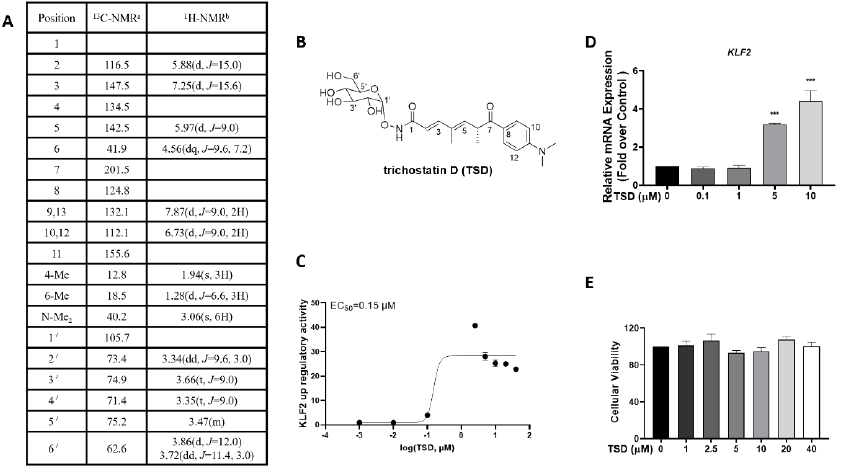
Figure 1. Trichostatin D (TSD) was identified as a novel Krüppel-like factor 2 (KLF2) activator. ( A ) Proton and carbon nuclear magnetic resonance spectroscopy ( 1 H-NMR and 13 C-NMR) data of TSD. ( B ) Chemical structure of TSD. ( C ) KLF2 dose-response curve of TSD. COS-7 cells were transfected with a KLF2-luc promoter-driven luciferase reporter plasmid (KLF2-Luc) for 6 h and then treated with the vehicle (0.1% DMSO) or TSD (0.001, 0.01, 0.1, 2.5, 5, 10, 20, and 40 μM) for 24 h. Then , the activity of the KLF2 luciferase reporter gene was analyzed. Values are represented as the mean ± SEM; n = 3. ( D ) TSD upregulated KLF2 mRNA levels in human umbilical vein endothelial cell (HUVECs) . HUVECs were treated with TSD (0, 0.1, 1, 5, and 10 μM ) for 24 h, and then, KLF2 mRNA levels were detected via real-time-quantitative polymerase chain reaction (RT-qPCR) with ACTB ( β - actin) as a reference. Values are represented as the mean ± SEM; n = 3; one-way ANOVA was used for analysis. *** p < 0.0001 vs. 0 μM. ( E ) Cell viability of TSD in HUVECs. HUVECs were inoculated in a 96- well plate and treated with different concentrations of TSD (0, 1, 2.5, 5, 10, 20, and 40 μM) for 24 h and then analyzed with a cell counting kit-8 (CCK-8) kit, as described in the Methods section. The absorbance was measured at 450 nm. Values are represented as the mean ± SEM; n = 3; one-way ANOVA was used for analysis.